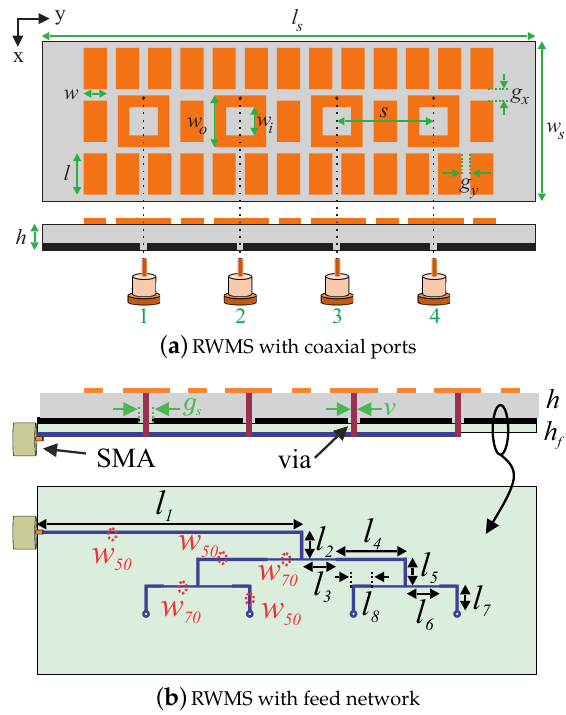
Figure 1. The 1 × 4 square ring elements embedded within metasurface and excited with ( a ) four coaxial probes and ( b ) feed network. The RWMS parameters are: w i = 10 mm, w o =20 mm, l = 16 mm, w = 9 mm, g x = 4.5 mm, and g y = 3.5 mm. The feed network parameters are: l 1 = 96.3 mm, l 2 = 10 mm, l 3 = 11.85 mm, l 4 = 25.65 mm, l 5 = 10 mm, l 6 = 11.85 mm, l 7 = 9.29 mm, l 8 = 6.9 mm, g s = 2.74 mm, v = 1.143 mm, w 50 = 1.1 mm, and w 70 = 0.7